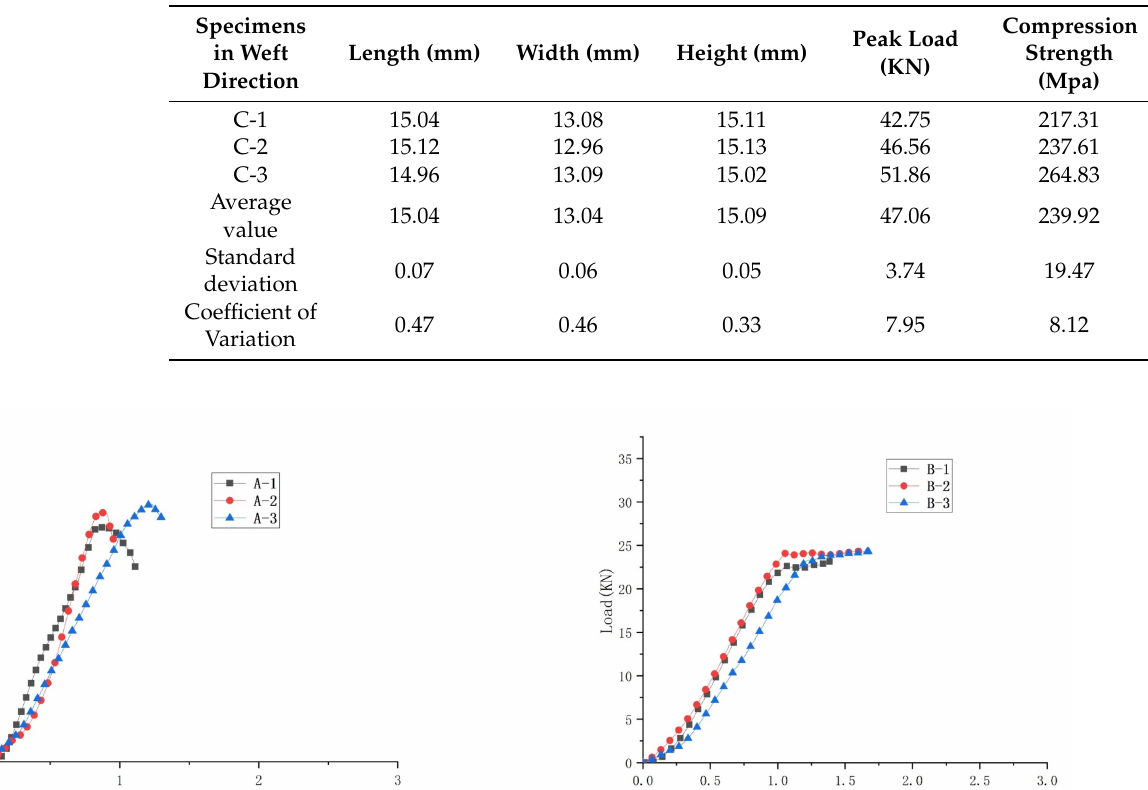
Table 4. Quasi-static compression test data for thickness specimens.